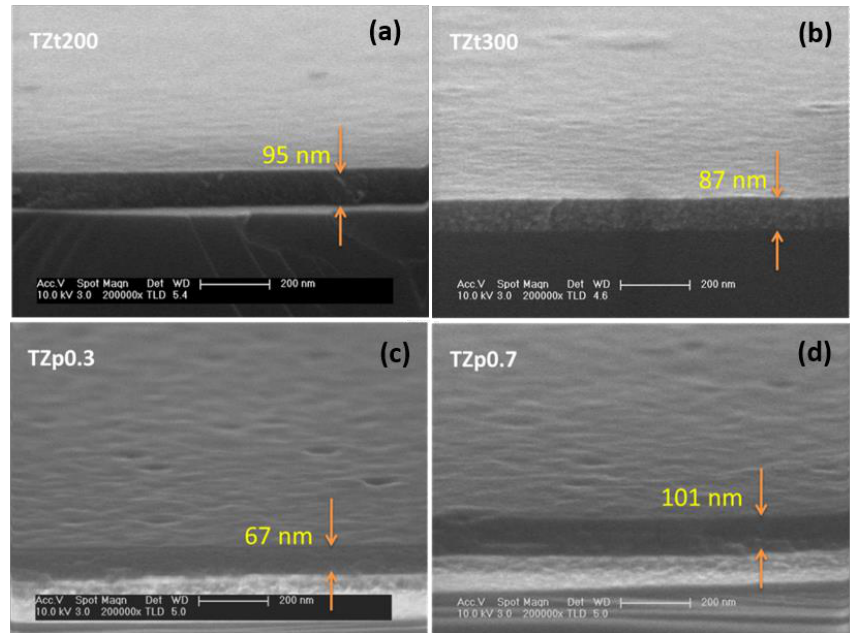
Figure 1. Tilt angle field-emission scanning electron microscopy (FESEM) images of Ti-doped ZnO thin films composed of 5 layers with different annealing conditions. ( a ) thermal annealing (TA) at 200 °C, ( b ) TA at 300 °C, ( c ) microwave plasma annealing (MwPA) at 0.3 mbar and ( d ) MwPA at 0.7 mbar.